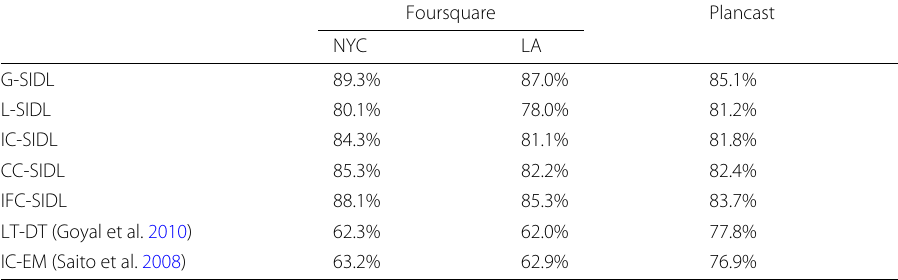
Table 3 Models performance in terms of accuracy: G-SIDL vs. L-SIDL vs. C-SIDL (IC-, CC-, and IFC-SIDL) vs. baseline models (LT-DT (Goyal et al. 2010) and IC-EM (Saito et al.